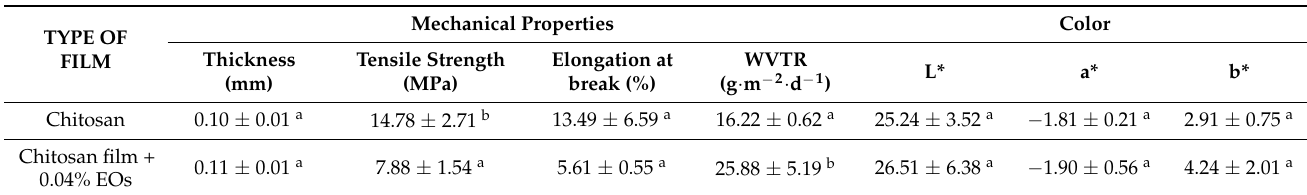
Table 3. Mechanical and physical properties of chitosan film and chitosan film incorporated with EOF:EOH at 0.04:0.04 (Chitosan film + 0.04% EOs). Values are mean ± standard deviation. Different letters in the same column indicate significant differences between the means using t -test ( p ≤